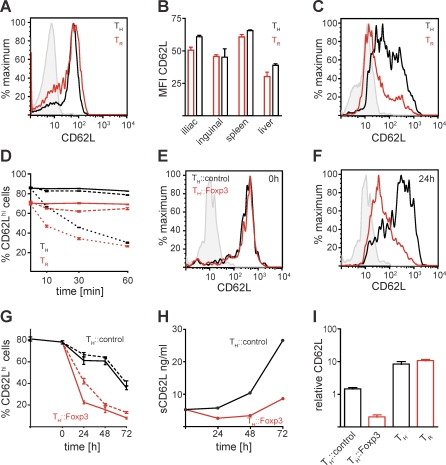
Foxp3-Mediated Regulation of CD62L(A–D) CD62L expression on CD4+Foxp3− TH cells (black) and CD4+Foxp3+ TR cells (red).(A) Representative FACS profiles for CD62L expression on TH and TR cells prepared from spleen (n = 3 in each case) with unstained TH cells (grey) shown as control.(B) Mean fluorescence intensity (MFI) of CD62L on TH and TR cells from indicated tissues (n = 2 in each case).(C) Representative FACS profiles of CD4+CD25− TH (black) and CD4+CD25+ TR (red) cells activated for 72 h (n = 3 in each case).(D) Total splenocytes were incubated in the absence of any treatment (solid line) or activated by addition of 100 ng/ml PMA in the presence (dashed line) or absence (dotted line) of 50 μM TAPI-2 (n = 3 in each case).(E–I) CD62L expression in TH::control (black) and TH::Foxp3 cells (red). CD4+CD25− cells were activated for 36 h and transduced (0 h) with either m6p8[control] (black line; n = 3) or m6p8[Foxp3] (red line; n = 3). (E and F) Representative FACS profiles of CD62L expression on transduced cells at (E) 0 h and (F) 24 h after transduction.(G) Percentage of CD62Lhi cells within the transduced populations in the presence (dashed line) or absence (solid line) of 50 μM TAPI-2.(H) Amount of soluble CD62L in the supernatant measured by ELISA (representative of two independent experiments).(I) Relative CD62L expression in CD4+CD25− TH and CD4+CD25+ TR cells (n = 3 in each case), as well as TH::control and TH::Foxp3 cells 48 h after transduction (n = 2 in each case) determined by qPCR and normalized to HPRT. Error bars represent the SEM.